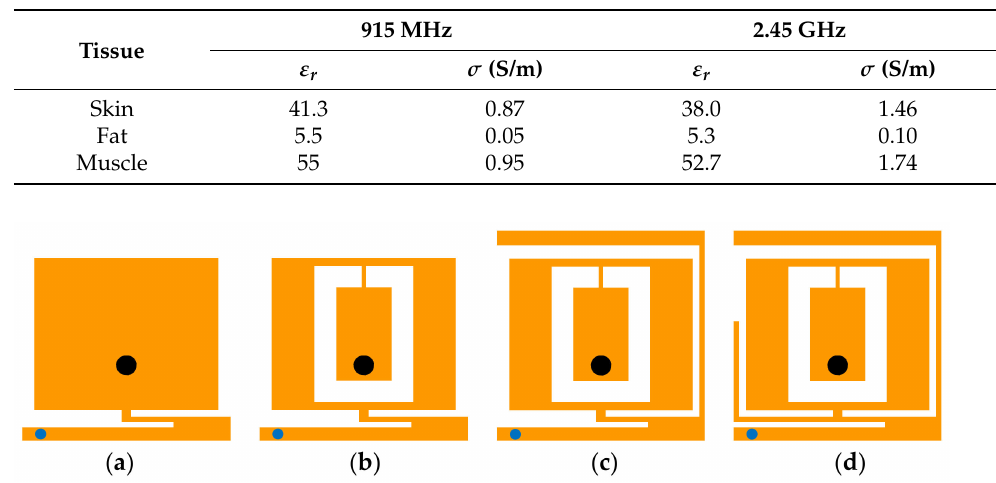
Figure 3. Evolution of the proposed antenna topology in ( a ) Case 1, ( b ) Case 2, ( c ) Case 3, and ( d ) Case 4.